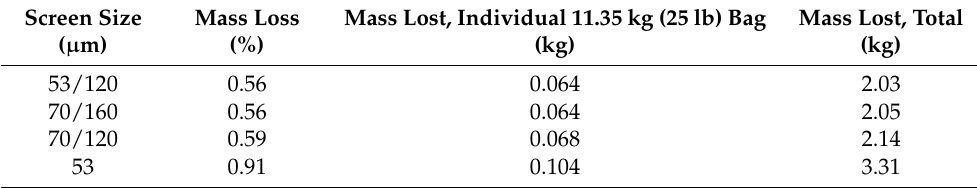
Table 1. Mass loss calculation over a one month period for the full-scale system. A bag weight of 11.35 kg was assumed. Mass Loss, Total considers all 32 bags in the